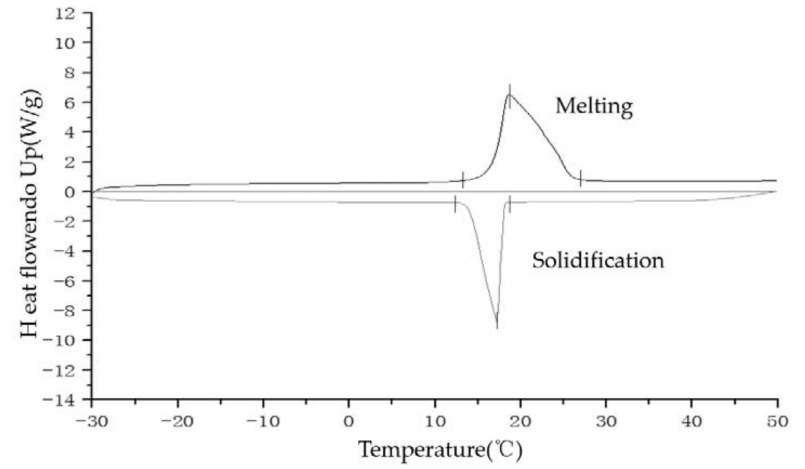
Figure 3. PCM phase change process according to the Differential Scanning Calorimeter (DSC) testing curve.